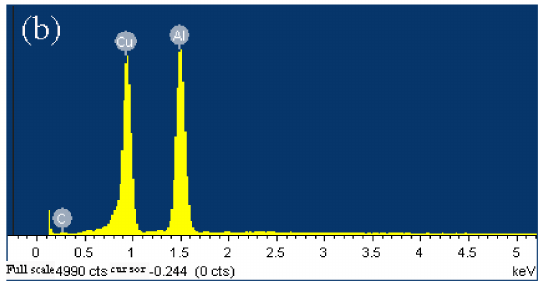
Figure 9. Energy spectrum pattern of infiltration alloy: ( a ) SEM micrograph of C/C–Al–Cu; and ( b ) component